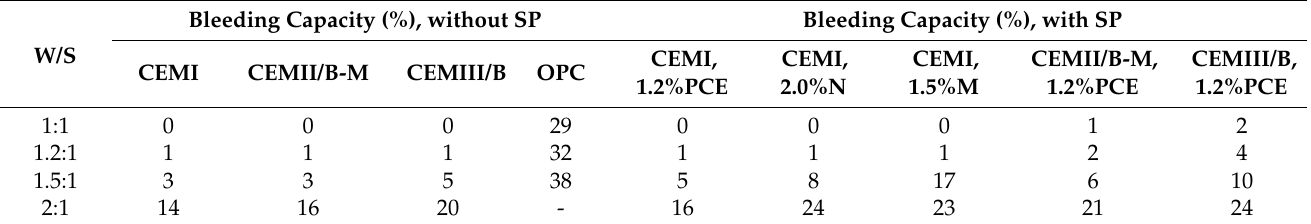
Table 5. Bleeding capacity of fresh SMCG with different SP, cement type and W/S in this